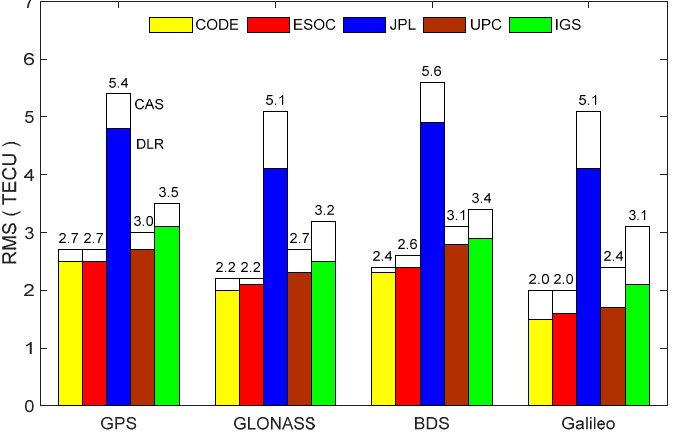
Figure 2. RMS statistical values of slant TEC derived from different GIM products based on the CAS (white bar) and DLR (color bar) multi-GNSS DCB corrections.